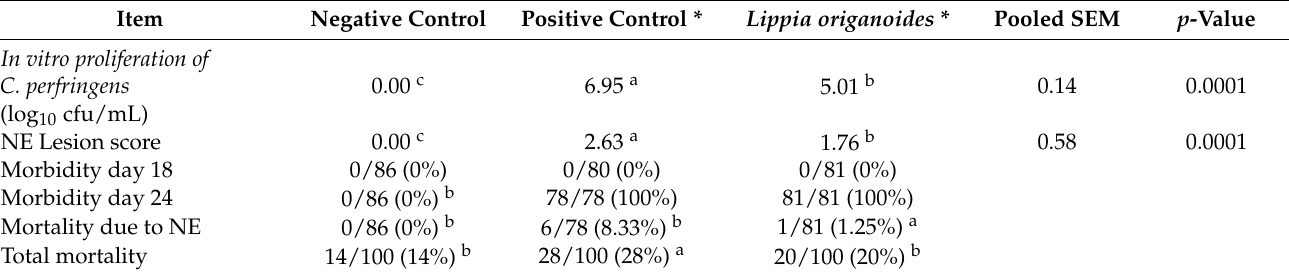
Table 4. Evaluation of Clostridium perfringens proliferation using in vitro digestion assay, necrotic enteritis (NE) lesion score, morbidity and mortality in broiler chickens consuming a diet supplemented with 37-ppm Lippia origanoides essential oils on a necrotic enteritis challenge model *.